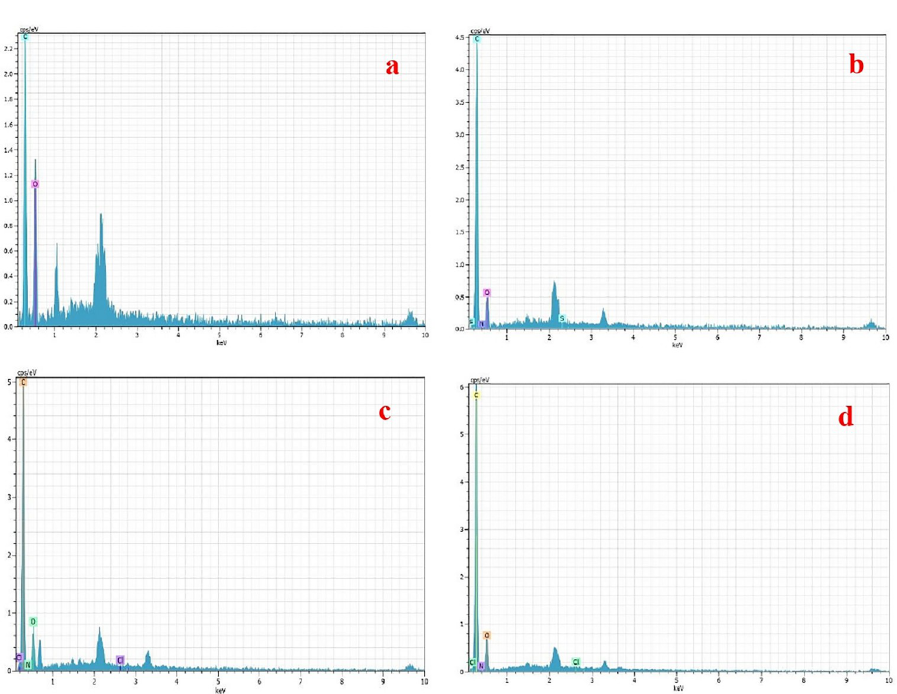
Fig 3. EDX of MC (a), MC after adsorption of BG (b), MC after adsorption of MG (c), and MC after adsorption of SA